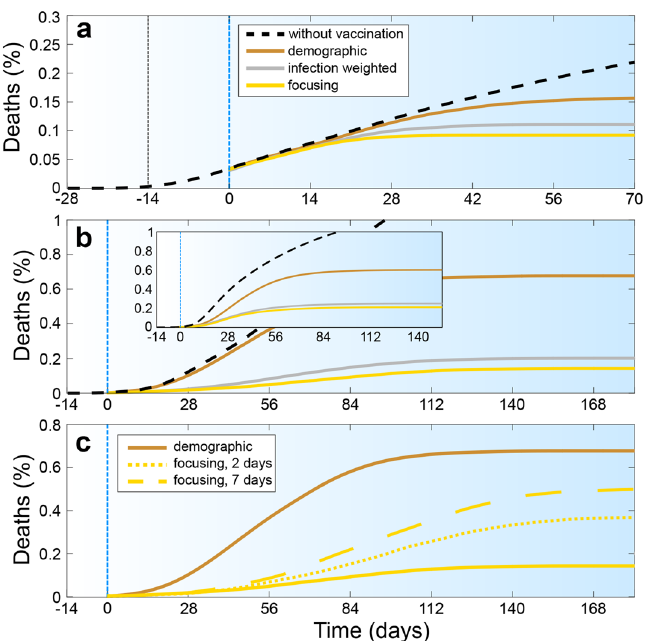
Figure 4. Competition of spatiotemporal vaccination strategies ( a ) in the presence of social distancing which is activated after 14 days (black vertical line) and reduces the reproduction number to R density distribution following Zipf’s law. Colors and parameters are as in Fig. 2 but we have N L 2.7 (which is based on D 700 , R 0 = = Analogous results for the mean-field model using same parameters as in the agent-based model and a 140 140-grid with each grid point corresponding to a spatial area of 5 R c Fig.